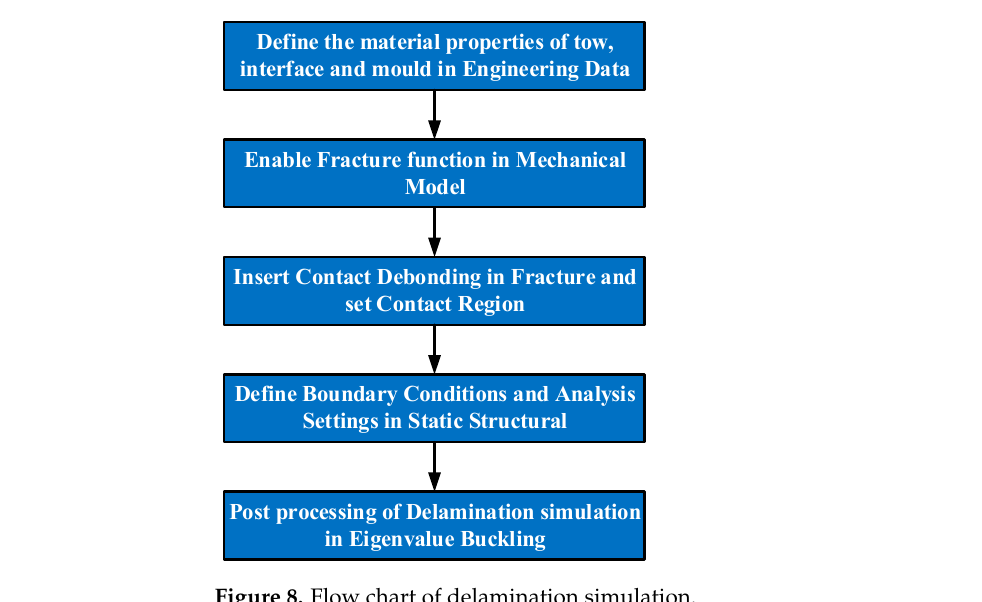
( b ) Figure 7. Nephogram of finite element simulation results: ( a ) Simulation results of contact stress; ( b ) Simulation results of roller strain. By observing the stress and strain nephogram of the flexible compaction roller, it can be concluded that the normal contact stress and strain are distributed in a parabolic curve along the width direction, which is consistent with the theoretical equation of pressure distribution and further proves the feasibility of applying Hertz theory to the compaction contact model. 4.2. Simulation Model of Angential Contact and Buckling The key to establishing the buckling simulation model in VATS is to determine the characterization method of the adhesion coefficient between the prepreg tow and the mold. Since the adhesion can inhibit the occurrence of buckling, delamination and other defects of the tow, it can be regarded as a connection mode between the tow and the mold. Therefore, this paper simulates the adhesion (tackiness of prepreg tow) with reference to the interface crack failure form of the adhesive structure. The interface delamination sim- ulation methods in ANSYS software include virtual crack closure technology (VCCT) and cohesive zone materials (CZM).